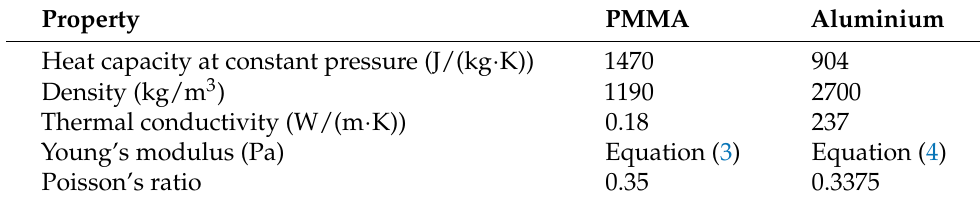
Figure 1. A 0 and S 0 group velocity dispersion curve shift with temperature from 20 °C to 100 °C for Aluminium 1050 H14. Table 1. COMSOL material